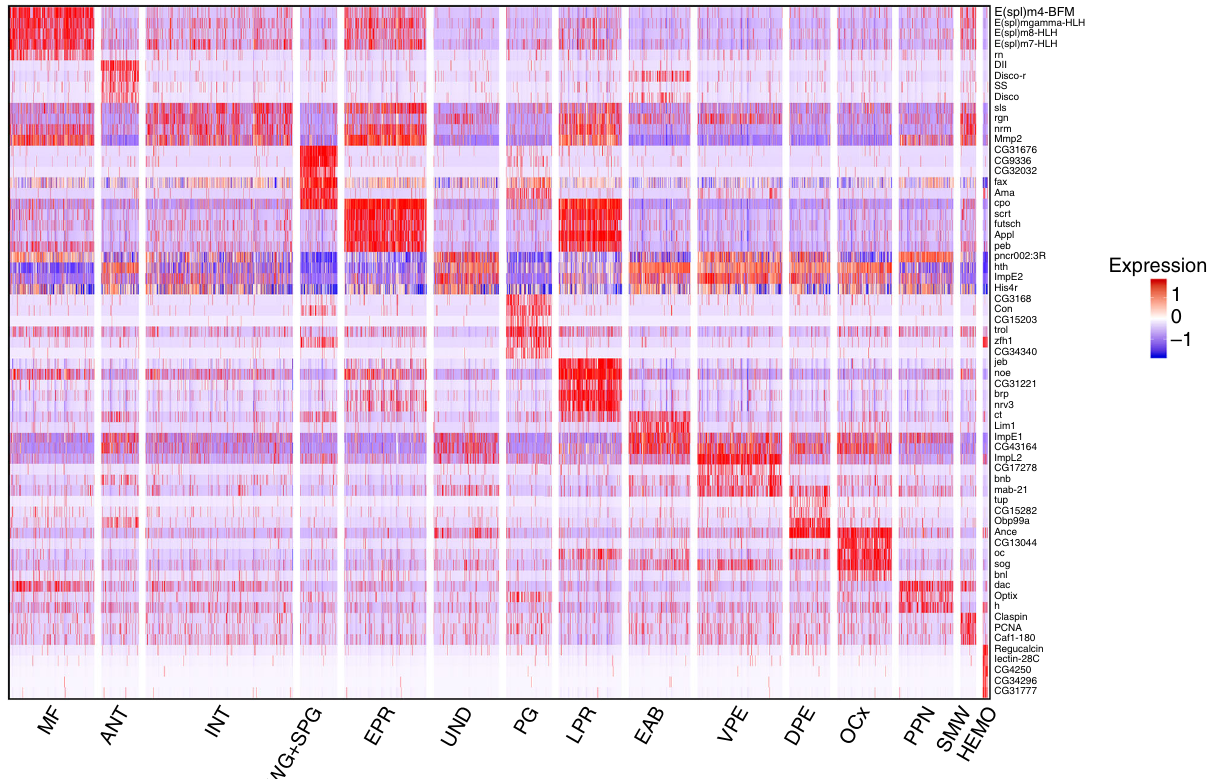
Fig. 2 A heat map showing markers across cell populations. Heat map displaying the expression of 65 top markers across 15 wild-type